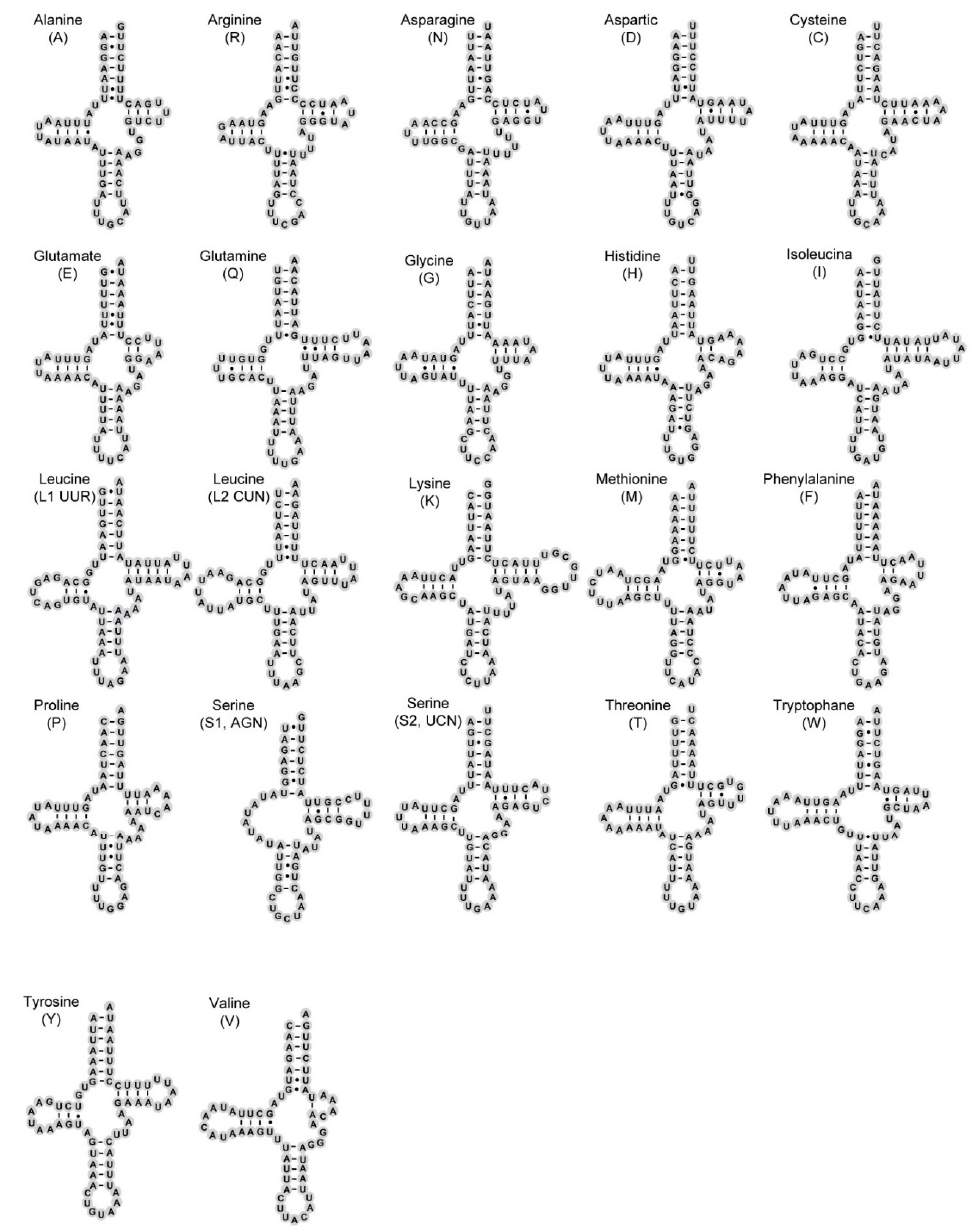
Figure 4. Predicted secondary cloverleaf structure for the tRNAs of T. sagittata .